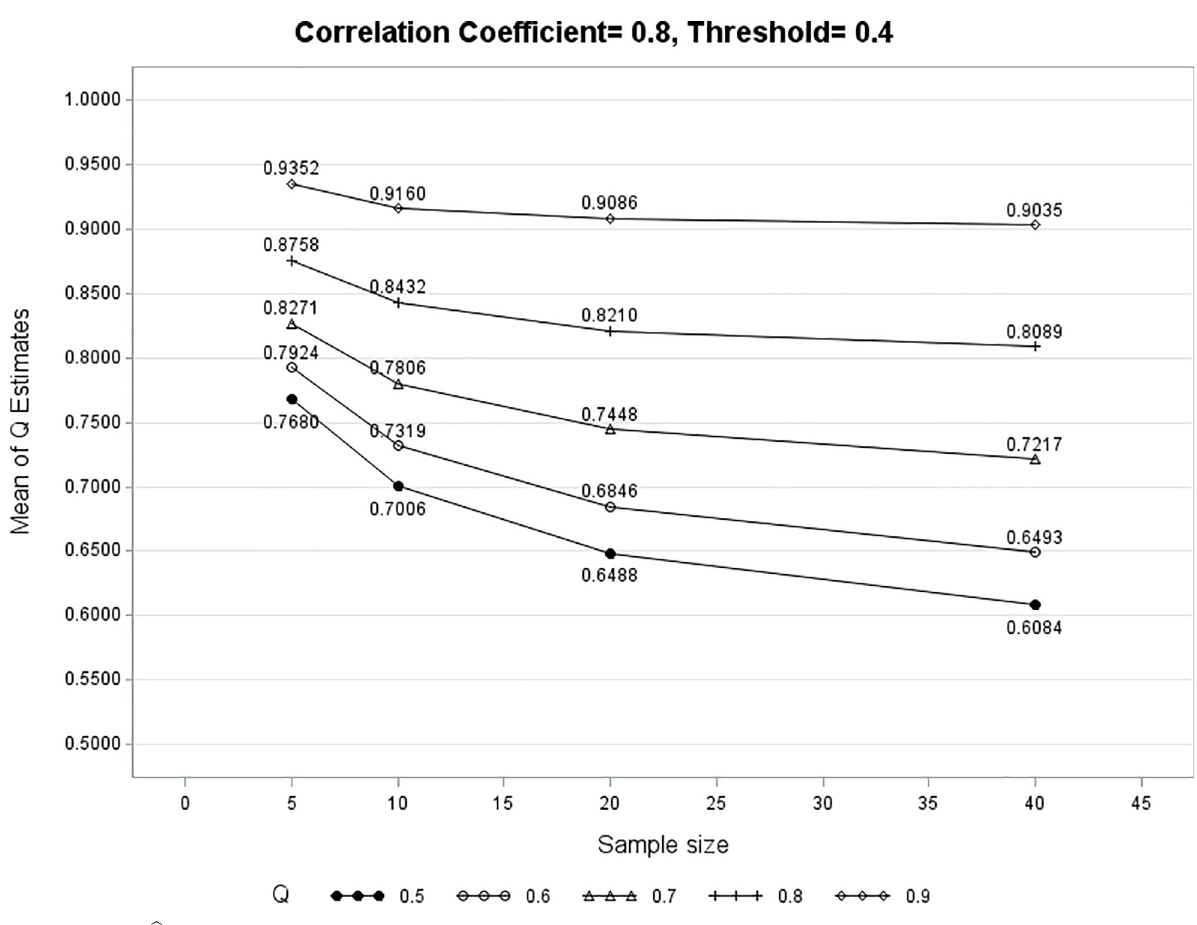
Fig 5. The mean b Q converges to its underlying value of Qiz as sample size increases ( ρ = 0.8, aiz = 0.4). iz